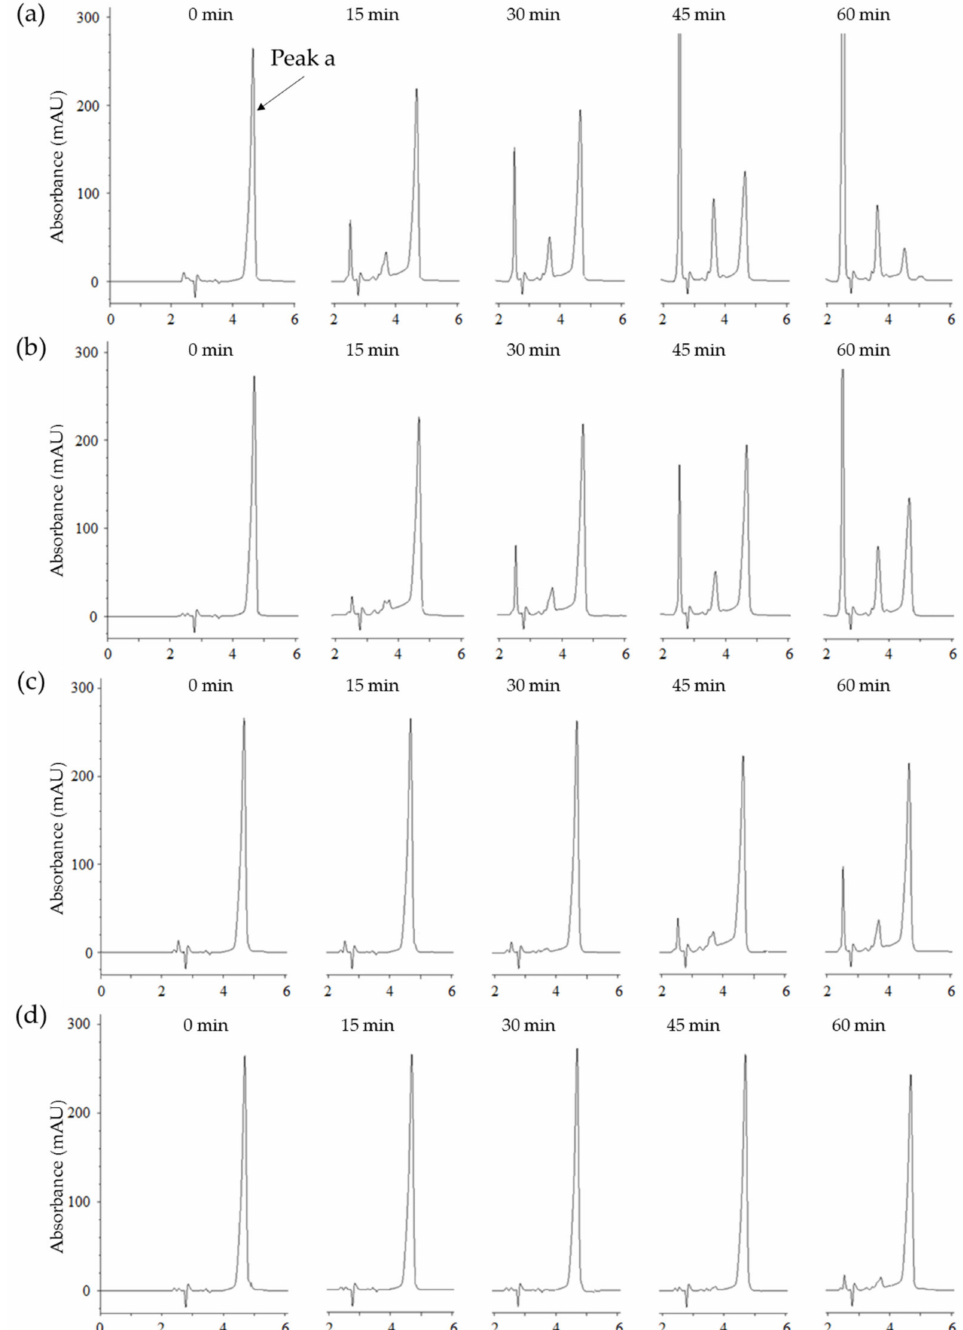
Figure 5. ( a ) High-performance liquid chromatography (HPLC) analysis of change in the content of N -acetyl-L-tyrosine (peak a, tR = 4.6 min) as a substrate for tyrosinase at di ff erent incubation times (0, 15, 30, 45, and 60 min) in the absence of compound 1 . ( b ) in the presence of 5.0 µ M compound 1 . ( c ) in the presence of 10 µ M compound 1 . ( d ) in the presence of 20 µ M compound 1